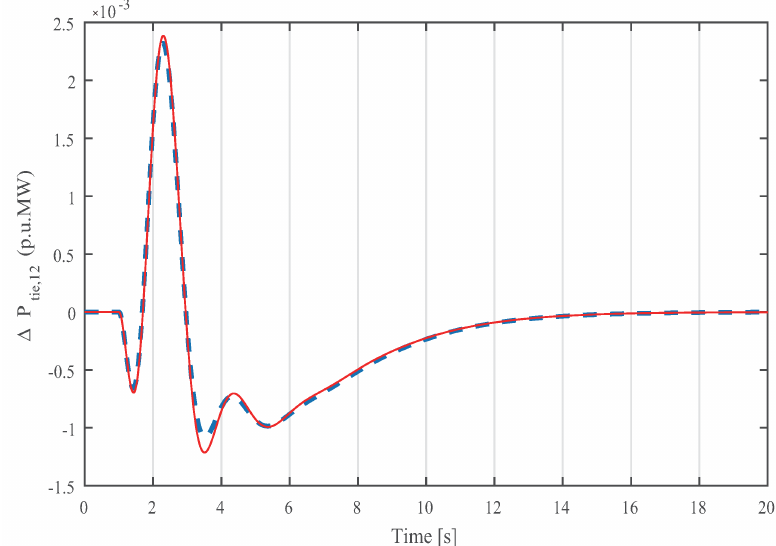
Figure 10. Power flow of V2G system subjected to SOC(solid: 1.2 multiples, dashed: 0.8